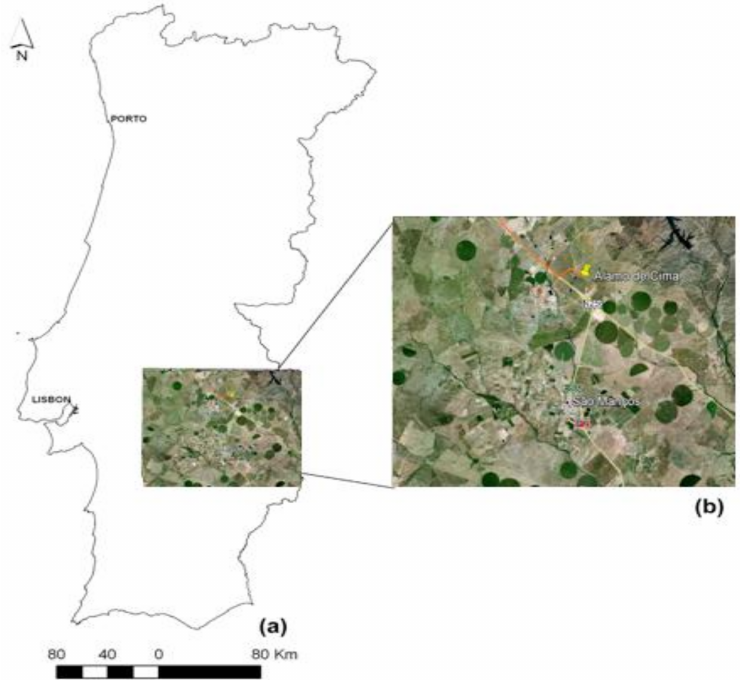
Figure 1. Location of the study area in southern Portugal ( a ) with identification of the intensive commercial olive orchard at the Herdade Á lamo de Cima near É vora (38 ◦ 29 (cid:48) 49.44 (cid:48)(cid:48) N, 7 ◦ 45 (cid:48) 8.83 (cid:48)(cid:48) W; alt. 75 m), in the Alentejo region ( b